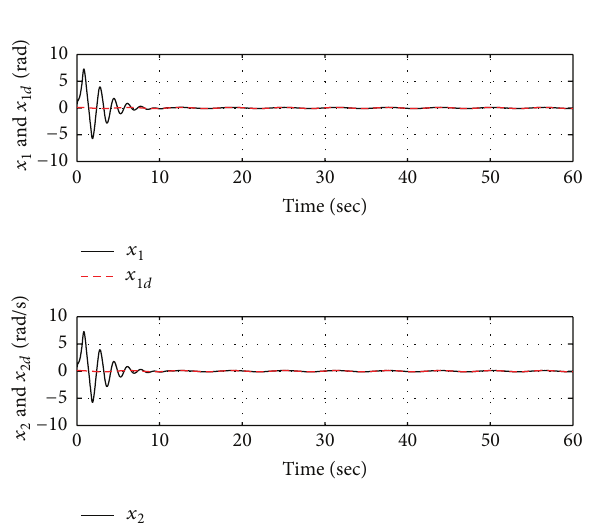
Figure 9: The control law 𝑢 .